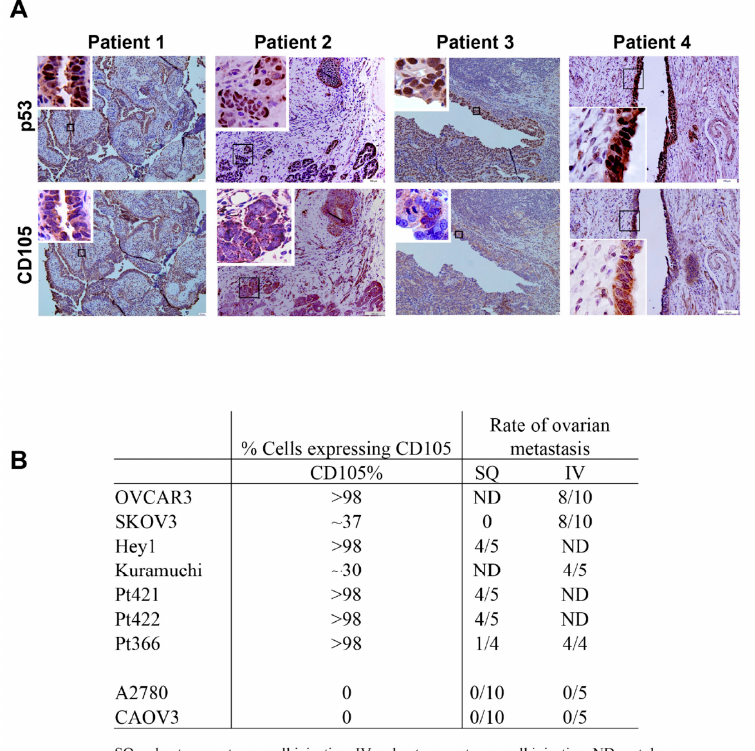
Figure 1. CD105 expression in fallopian tube serous tubal intraepithelial carcinoma (STIC) lesions and hematogenous ovarian metastasis of CD105-expressing cancer cells. ( A ) p53 IHC confirming strong nuclear p53 expression in STIC lesions, and CD105 IHC demonstrating CD105 expression in STIC lesions. Boxed areas indicate regions of high-power insets. ( B ) Summary of CD105 expression and rate of intravenous metastasis to the ovary of the indicated ovarian cancer cell lines and primary patient-derived